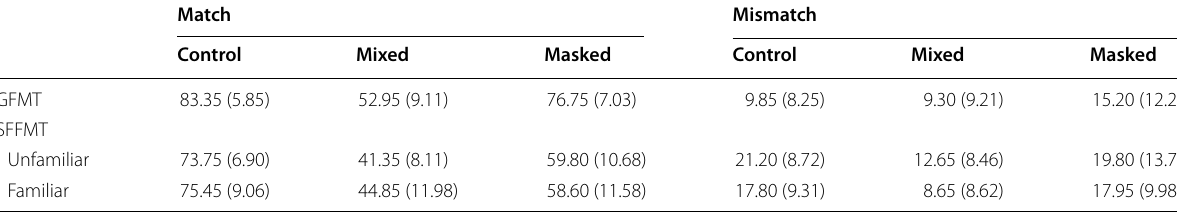
Table 6 Descriptive statistics [means(SD)] for the similarity ratings given by the DNN for the match and mismatch trials of the GFMT and the